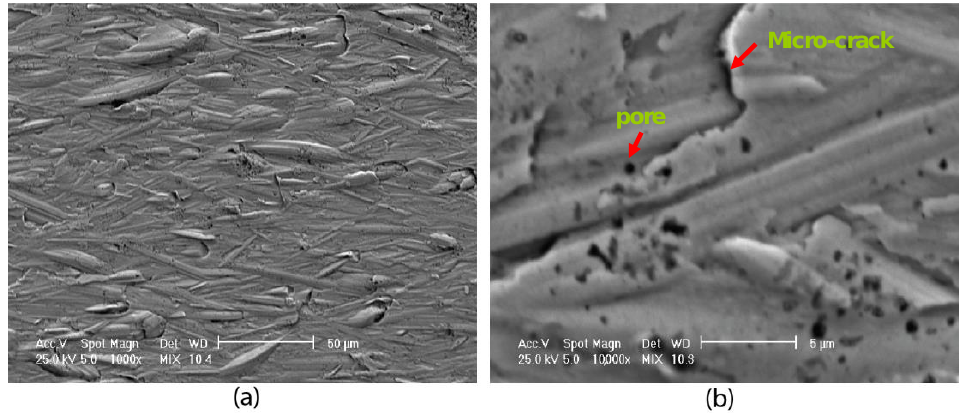
Figure 10. SEM morphology of the equimolar CoCrFeMnNi thin film, sample 1 (corroded): ( a ) ×1000; ( b ) ×10,000.